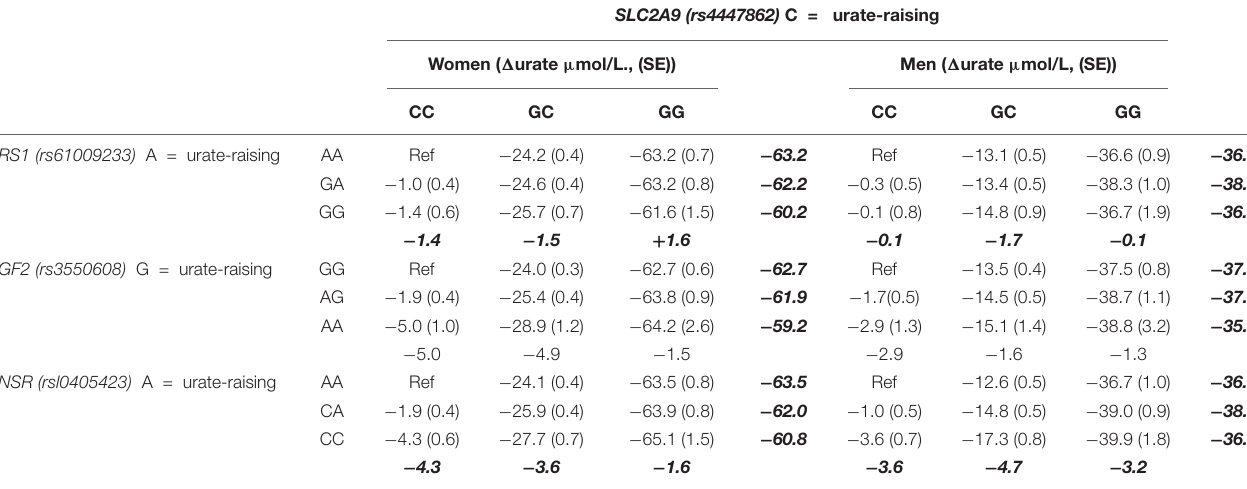
TABLE 1 | Association of the SLC2A9 locus vs each of the IRS1 / IGF2 / INSR loci with serum urate levels stratified by sex and by genotype in the United Kingdom Biobank. SLC2A9 (rs4447862) C = urate-raising Women ( (cid:49) urate µ mol/L., (SE)) Men ( (cid:49) urate µ mol/L,